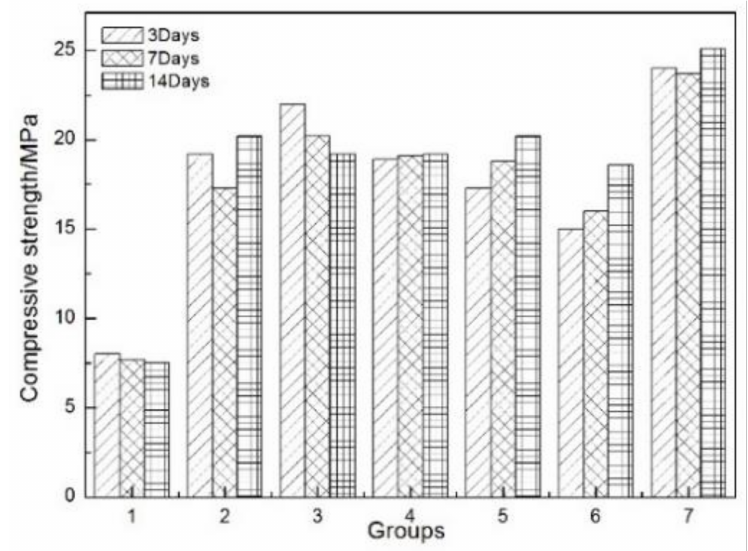
Figure 6. Compressive strength of 45% added